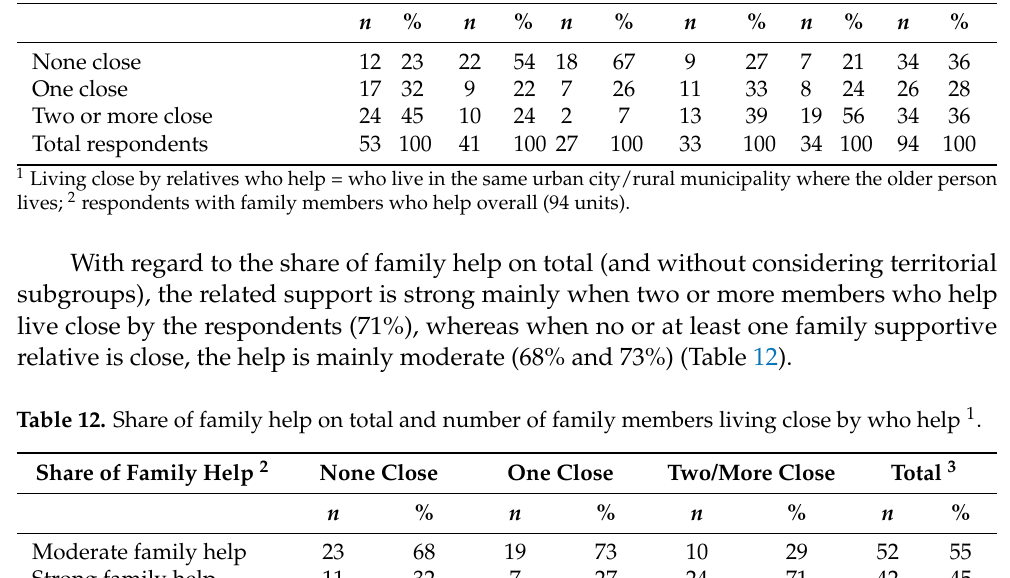
Table 11. Number of family members living close by who help, by sites and regions. Close by Family Members 1